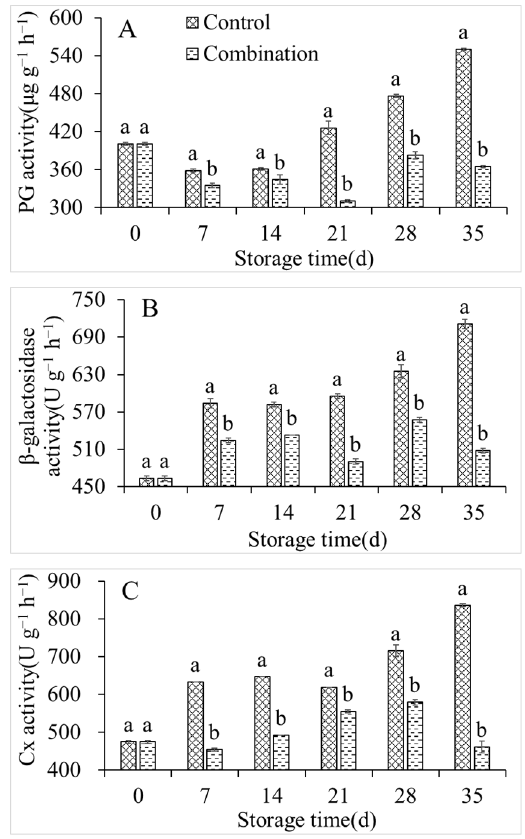
Figure 5. PG ( A ), β -galactosidase ( B ), and Cx ( C ) activities of peaches during storage at 5 °C. Vertical bars indicate the standard errors of three replications. Different lowercase letters at same storage time points are significantly different ( p < 0.05).